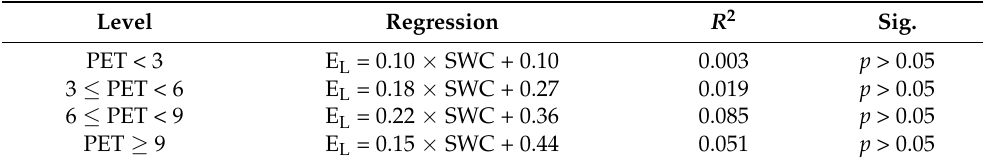
Figure 9. Plot showing the role of SWC in response of canopy transpiration to PET in the study period. ( a ) PET; ( b ) SWC. Table 5. The response of Ec to PET under varying